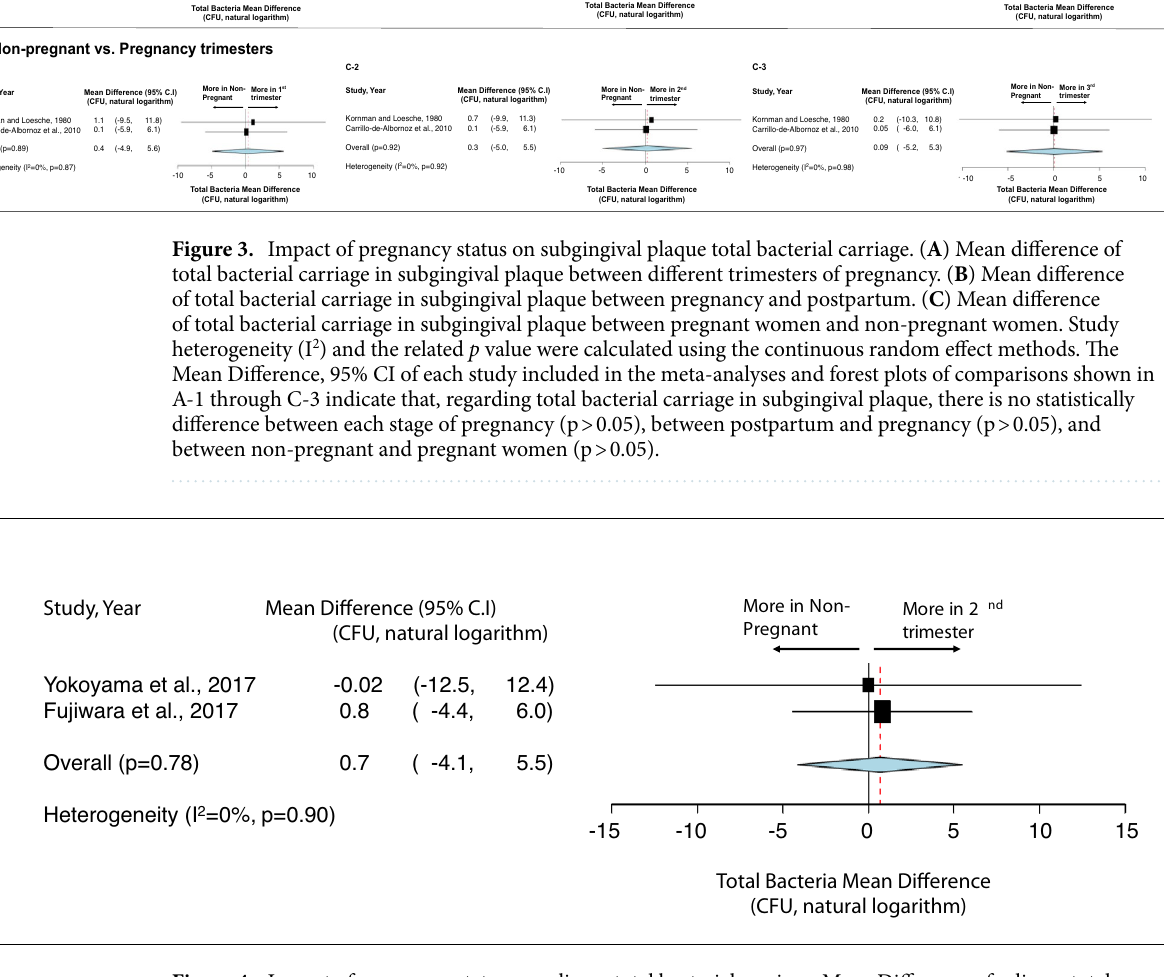
Figure 4. Impact of pregnancy status on salivary total bacterial carriage. Mean Difference of salivary total bacterial carriage in non-pregnant and 2nd trimester pregnant women. Study heterogeneity (I 2 ) and the related p value were calculated using the continuous random effect methods. The Mean Difference, 95% CI of each study included in the meta-analysis and forest plot of comparisons indicate that, regarding salivary total bacterial carriage, there is no statistically significant difference between non-pregnant and 2nd trimester pregnant women ( p >